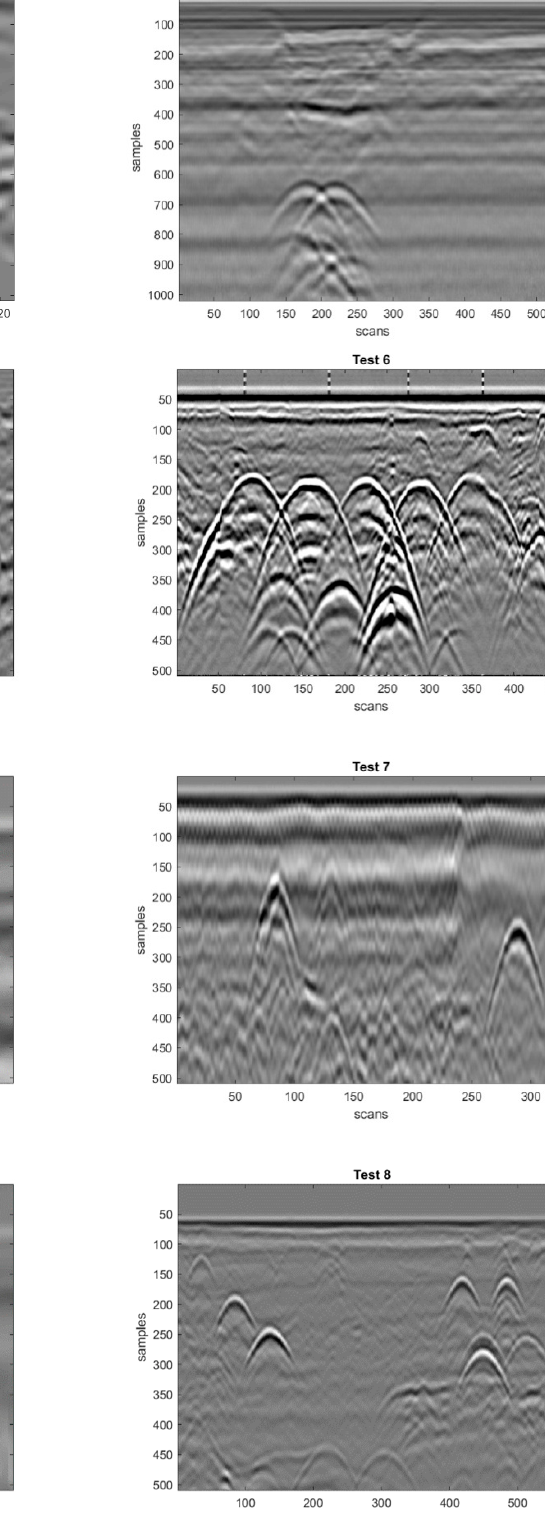
Figure 5. Experimental radargrams collected during real GPR surveys.